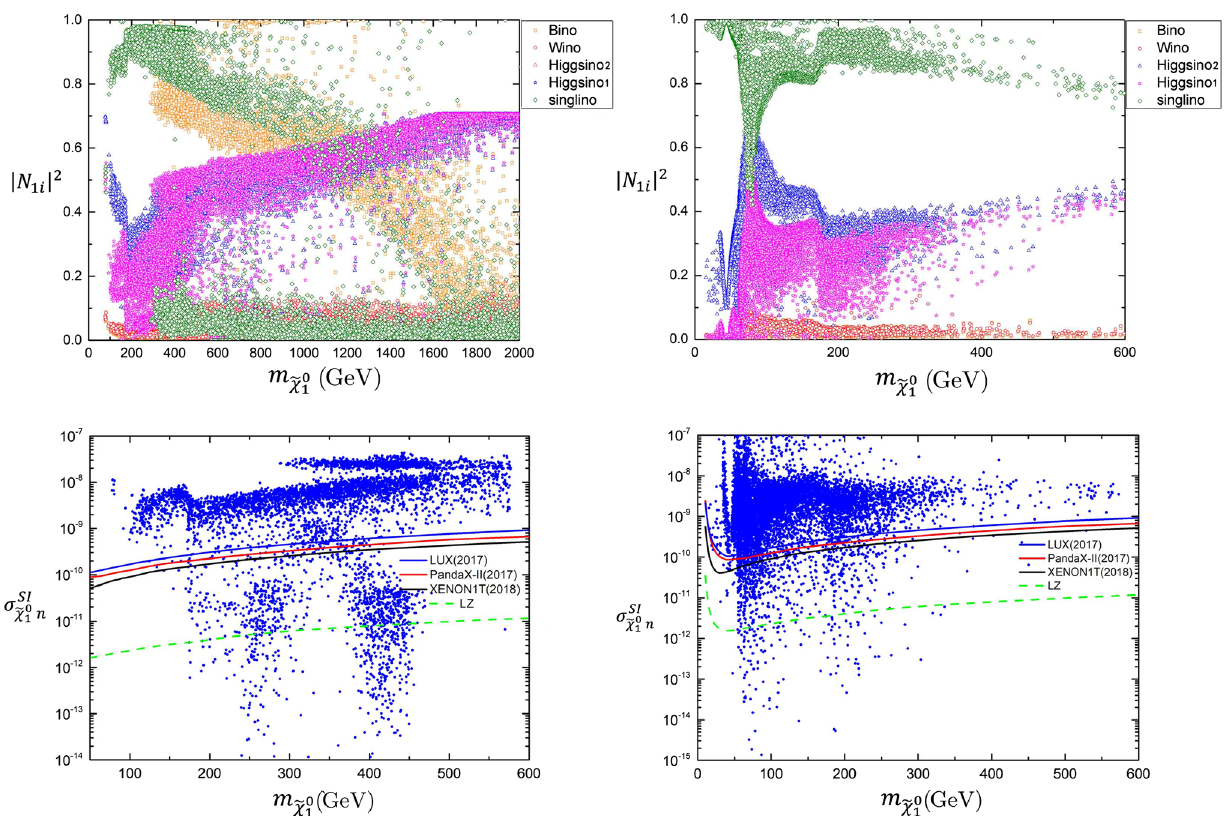
Fig. 5 The upper panels show the plots of DM mass vs the DM components for Type A (left panel) or Type B (right panel). Similarly, the lower panels show the plots of DM mass versus the spin-independent (SI) direct detection bounds. All samples satisfy the constraints from